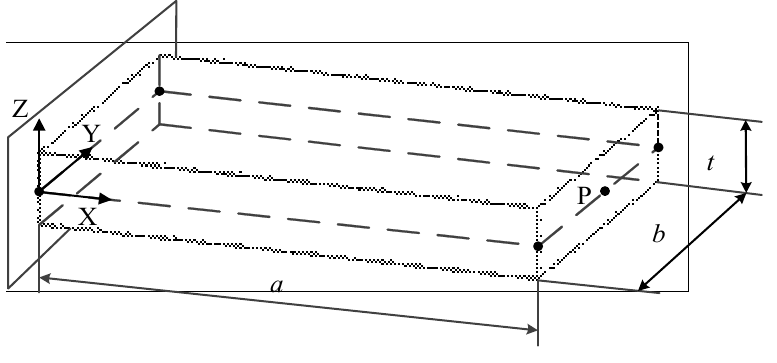
Figure 3. The silicone rubber cantilever plate.